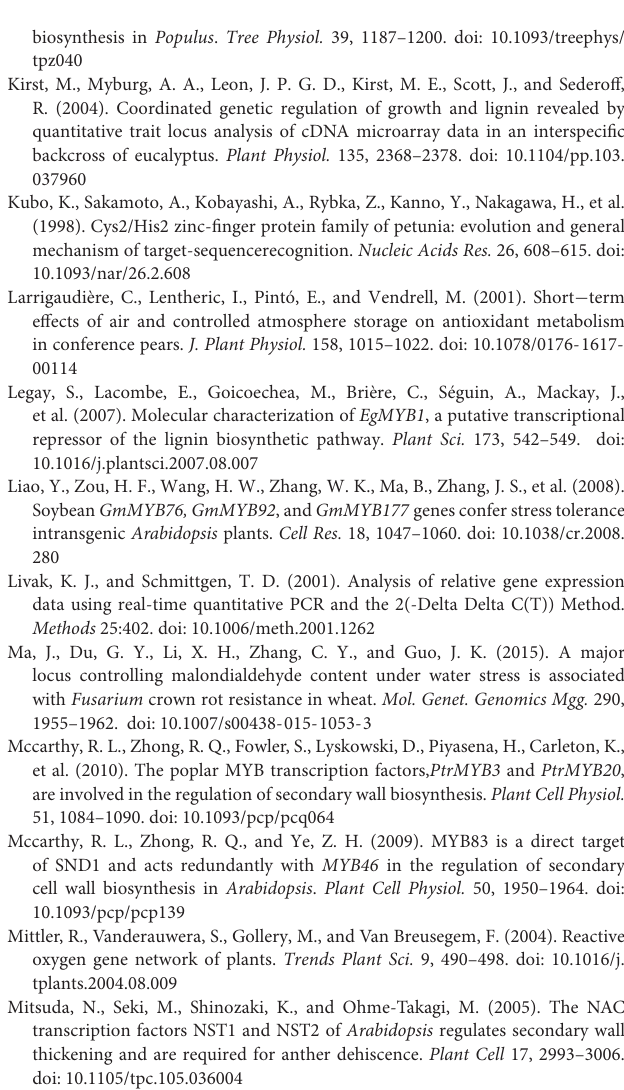
Supplementary Figure 2 | Observation of transgenic Arabidopsis phenotype. Comparison of transgenic Arabidopsis and WT at 1 week (A) , 4 weeks (B) , and 6 weeks (C) . Supplementary Table 1 | Vector construction primer sequence. Supplementary Table 2 | qRT-PCR primer